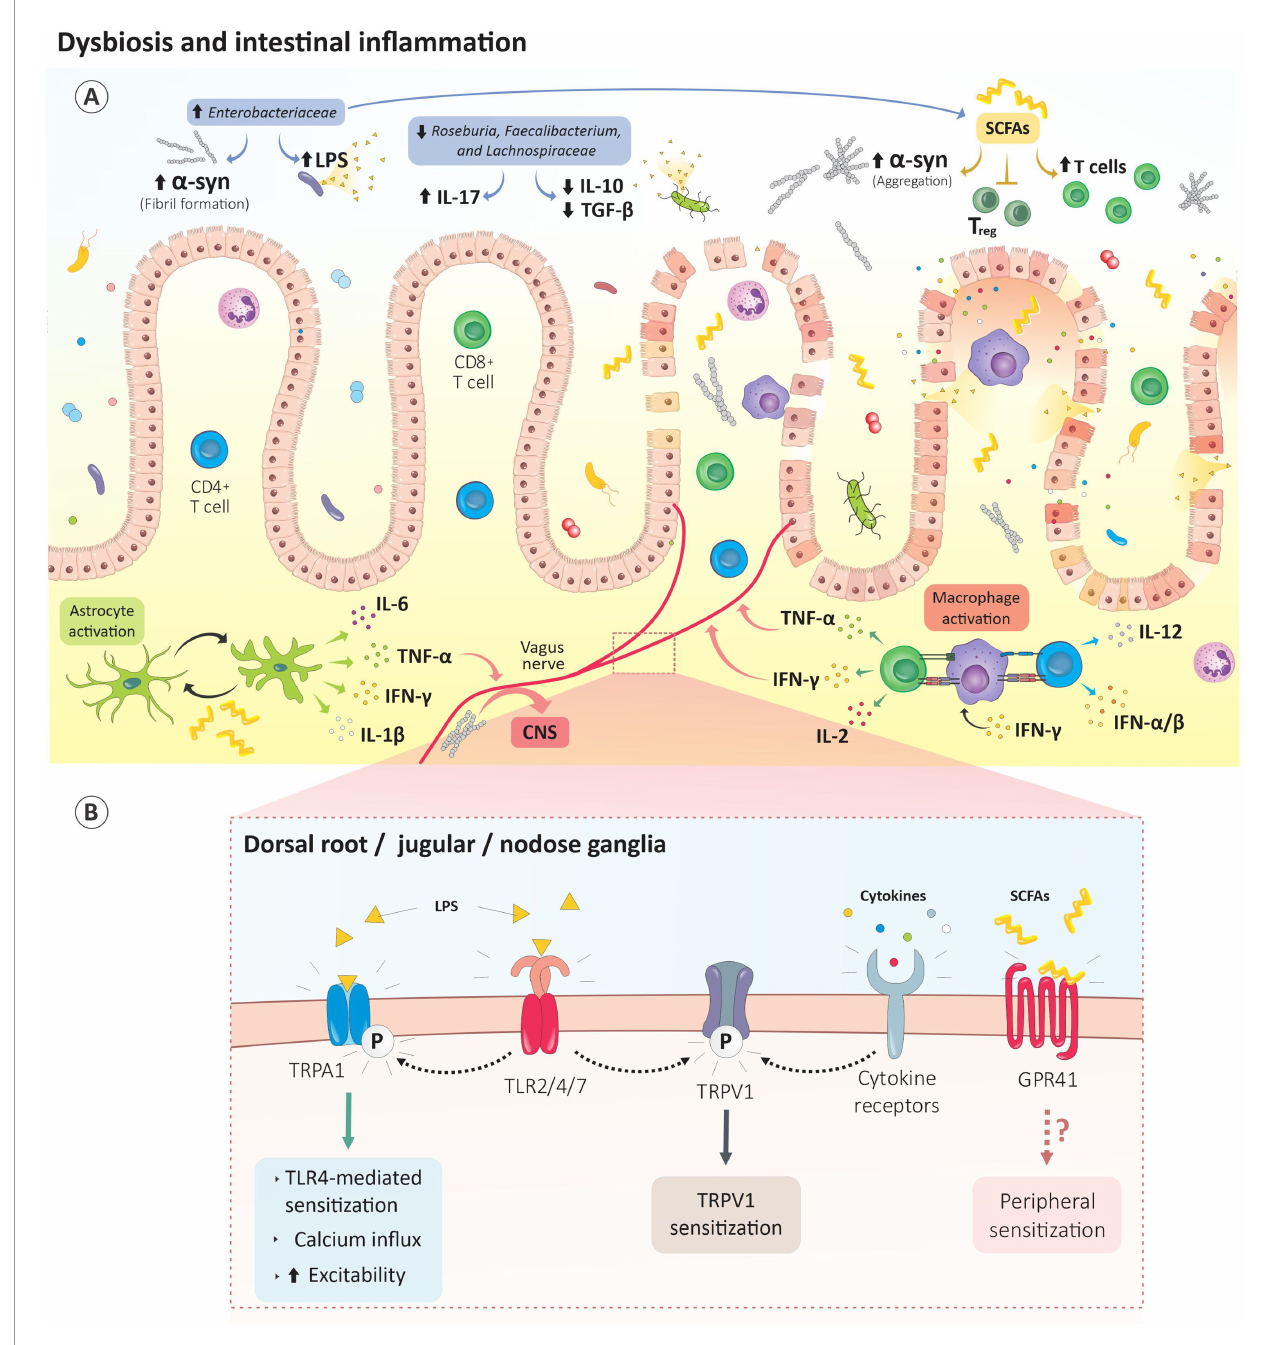
FIGURE 3 | Gut dysbiosis drives PD-induced pain. (A) The gut dysbiosis in PD is characterized by enhances Enterobacteriaceae content. These bacteria increase LPS levels which subsequently promote gut permeability. Raises in Enterobacteriaceae metabolites, such as short-chain fatty acids, promote a ‐ syn fi bril formation, microglia activation and blunt T reg -mediated immunosuppression. Proteolyzed a -syn by neurons and antigen presenting cells is then presented by the MHC machinery and leads to activation of autoreactive CD8 and CD4 T cells. (B) The dysbiotic bacteria and their metabolites directly activate vagal or ENS neurons. For instance, LPS activates nociceptor neurons-expressed TLR2/4/7 while SCFAs sensitize GPR41-expressing neurons. Bacteria-activated or a -syn-autoreactive immunocytes released cytokines can also activate their cognate receptors on sensory neurons. Subsequently, intracellular mechanisms are triggered in these neurons and culminate in TRP channels phosphorylation, neurons sensitization and sensory hypersensitivity. CNS, central nervous system; GPR41, G protein-coupled receptor 41; IFN- g , interferon g ; IL-1 b , interleukin 1 beta; IL-2, interleukin 2; IL-6, interleukin 6; IL- 10, interleukin 10; IL-12, interleukin 12; IL-17, interleukin 17; LPS, lipopolysaccharide; TGF b , transforming growth factor beta; TLR2/4/7, Toll-like receptor 2/4/7; T reg , regulatory T cells TRPA1, transient receptor potential ankyrin-like 1; TRPV1, transient receptor potential cation channel subfamily V; TNF- a , tumor necrosis factor; SCFAs, short-chain fatty acids; a -syn, a